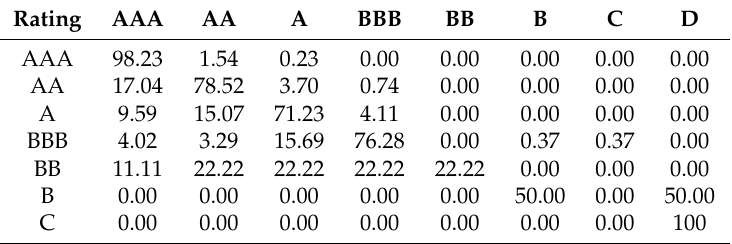
Table 1. CRISIL’s one-year mean transition rates (1993–2014)(%). Source: CRISIL Default Study 2014.